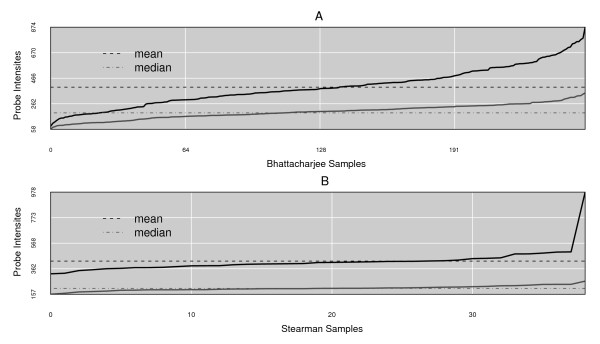
Background Estimation. Using the intensity (y-axis) of the set of low target-affinity probes (ΔG < -3.6 kcal/mol) over the complete set of samples in each experiment (x-axis), the median value approximates the scanner's lower limit specification: the value is 189 f.u. for the Bhattacharjee experiment arrays and 204 f.u. for the Stearman experiment arrays. The Stearman dataset has one obvious outlier (the final sample) which was detected and subsequently removed through our sample cleansing routines.